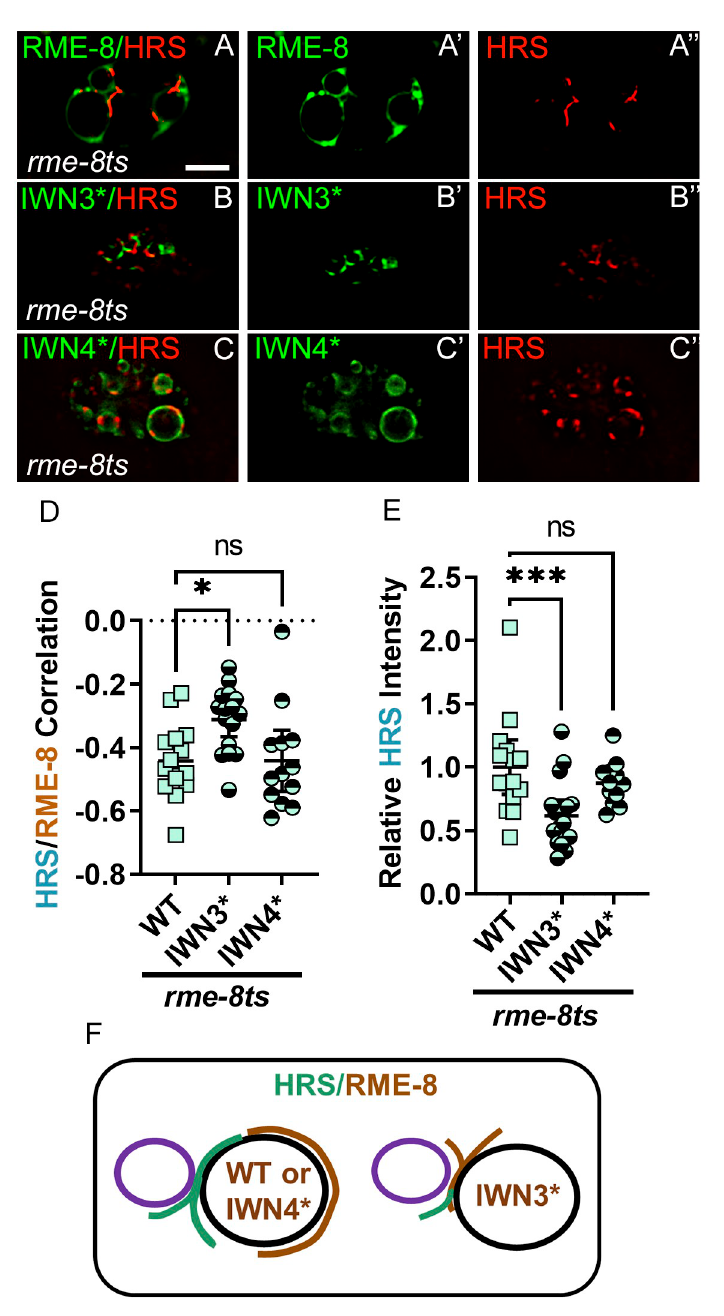
Fig 5. IWN3 � mutant alters both RME-8/HRS colocalization and HRS accumulation. (A-A”) Micrograph of pCUP- 4::GFP::RME-8 co-expressed with tagRFP::HRS(HGRS-1) in coelomocytes of rme-8ts animals. Single channels and the merge are displayed. (B-B”) Micrograph of pCUP-4::GFP::RME-8 D1657K mutation in IWN3 (IWN3 � ) co-expressed with tagRFP::HRS(HGRS-1) in coelomocytes of rme-8ts animals. Single channels and the merge are displayed. (C-C”) Micrograph of pSNX-1::tagRFP::HRS(HGRS-1) co-expressed with RME-8 IWN4 triple lysine substitution at positions 1962,1966, and 1967 (IWN4 � ) in rme-8ts mutant animals. Single channels and the merge are displayed (D) Quantification of colocalization of HRS(HGRS-1) with RME-8 WT, IWN3 � and IWN4 � . (E) Quantification of tagRFP::HRS/HGRS-1 average intensity rme-8ts mutant animals expressing RME-8 WT, IWN3 � and IWN4 � . (F) Illustration of the interior shift and increased HRS overlap of the RME-8 microdomain that occurs upon the introduction of D1657K in IWN3 (indicated in brown). Illustration of the shrinkage of the HRS(HGRS-1) microdomain upon the introduction of D1657K in IWN3 (indicated in green). Each data point is an individual worm, error bars indicate Mean with 95% CI, ANOVA statistical analysis done in Prism with p < 0.5 = � , p < 0.01 = �� , p < 0.001 = ��� , p < 0.0001 = ���� . Scale bars are 5 microns in whole coelomocyte images.